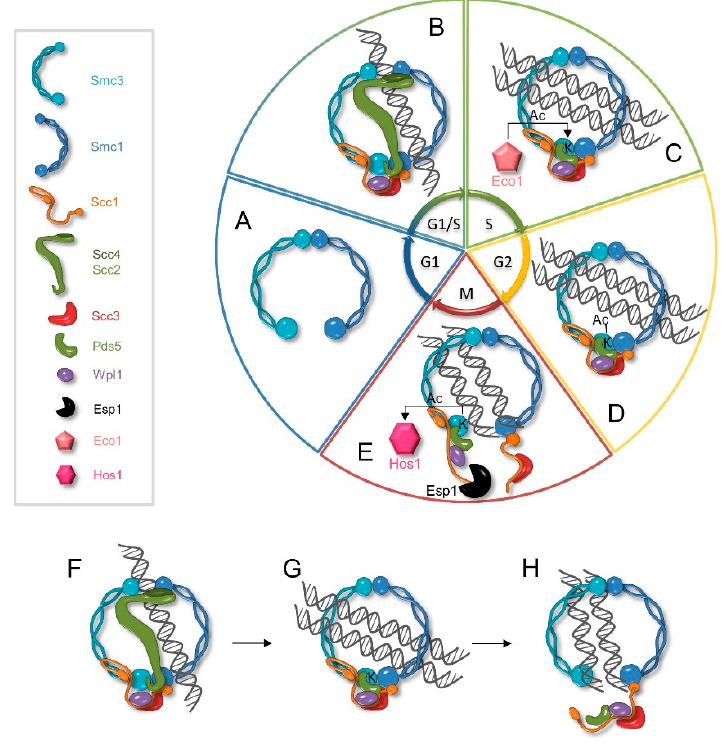
Figure 2. Possible cohesin cycle in yeast. In the G1 phase of the cell cycle, the cohesin complex does not form because Scc1 is absent ( A ). In the late G1/early S-phase Scc1 expression is reinduced allowing formation of the complete cohesin complex. Next, the chromatin-bound Scc2–Scc4 complex directs cohesin to specific chromosomal loci and facilitates cohesin loading reaction by creating an entry gate for the DNA, possibly by separating Smc1 and Smc3 hinge domains ( B ). During the S-phase, Eco1 acetylates some of the cohesins. This prevents Wpl1-dependent cohesin deposition and enables stable entrapment of sister chromatids ( C ), until mitosis cohesion is maintained by Pds5 and Scc3 ( D ). At the anaphase onset, the Esp1 separase cleaves Scc1, allowing Hos1 to deacetylate Smc3, which leads to cohesin removal from chromatin ( E ). Many cohesins loaded in G1/S or later ( F ) are not acetylated by Eco1 ( G ), and interact with the chromatin only transiently because Wpl1 imposes Scc1 dissociation from Smc3, creating an exit gate for DNA ( H ).